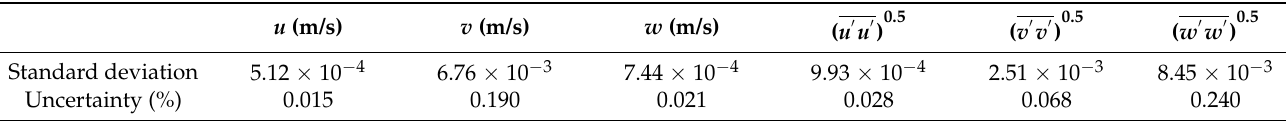
Table 2. Uncertainty of ADV